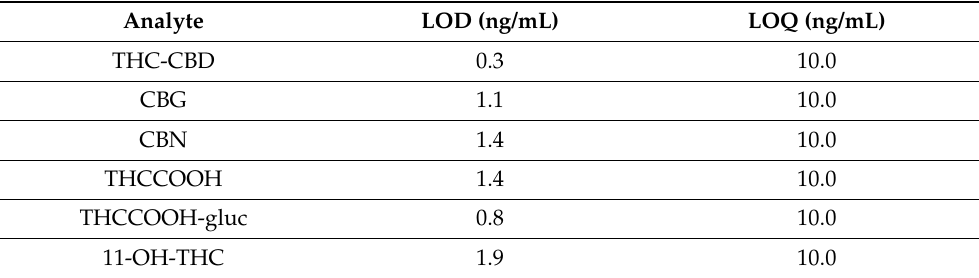
Table 2. Method sensitivity.